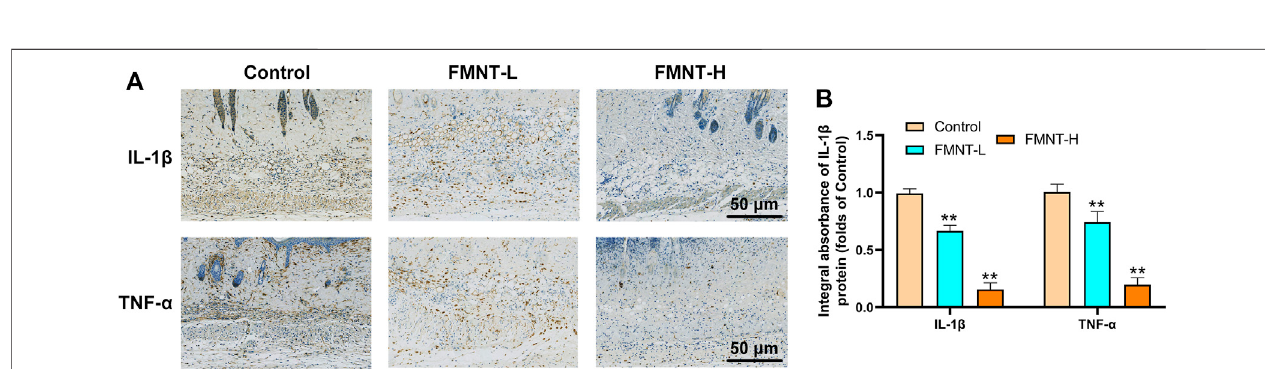
FIGURE 3 | (A) The expressions of IL-1 β and TNF- α were detected by immunohistochemistry in the tissue of the area II of the three groups of skin fl aps (scan bar: 50 μ m) (B) IHC of IL-1 β and TNF- α mainly expressed in vascular endothelial and stromal cells in fl aps. All data represent mean ± SD. ** p ≤ 0.01 compared to the control